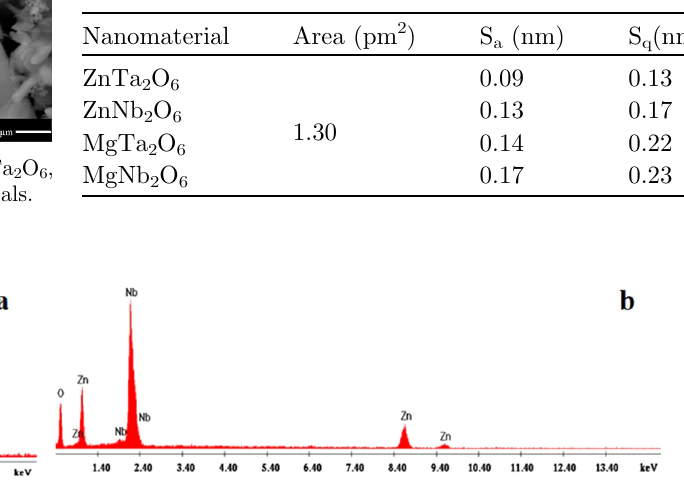
Table 2. The calculated S for the obtained